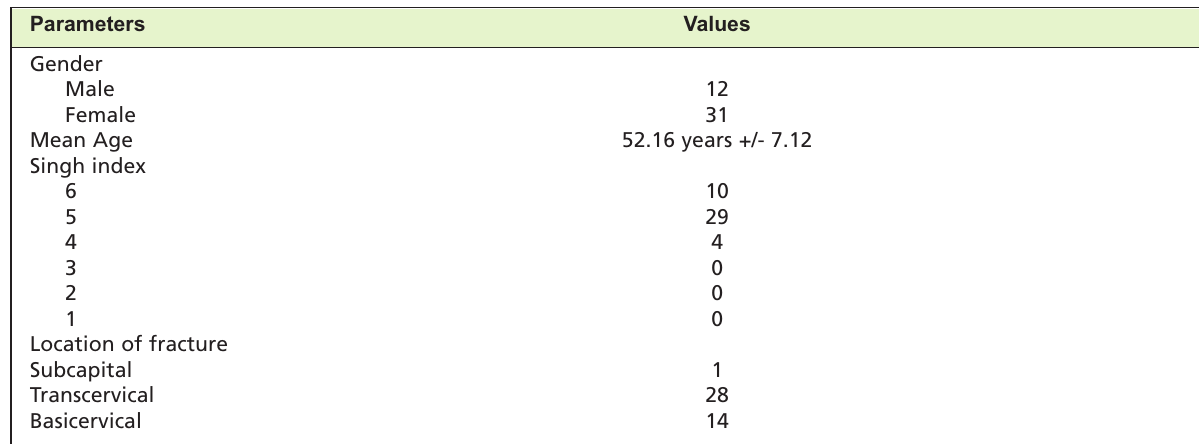
Control group Table V: